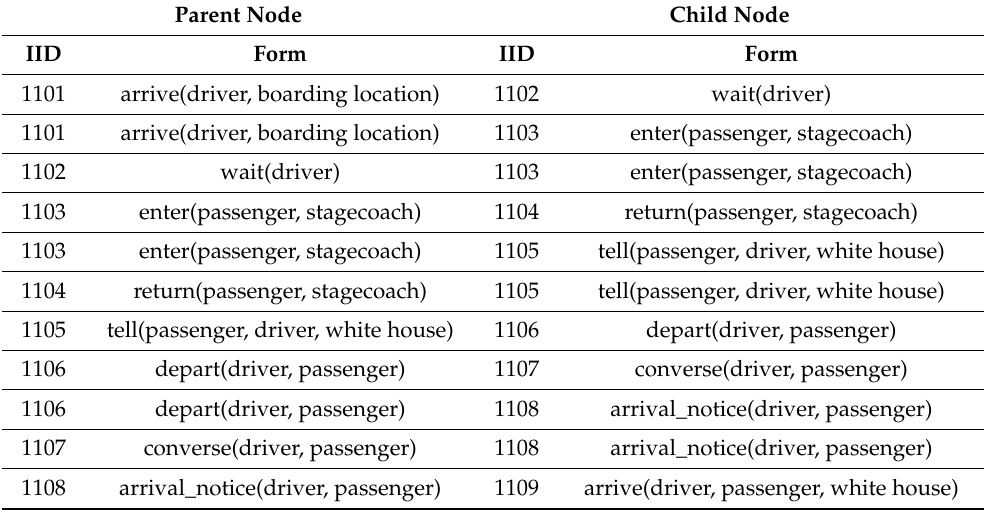
Table 1. The predicate form of the stagecoach cognitive